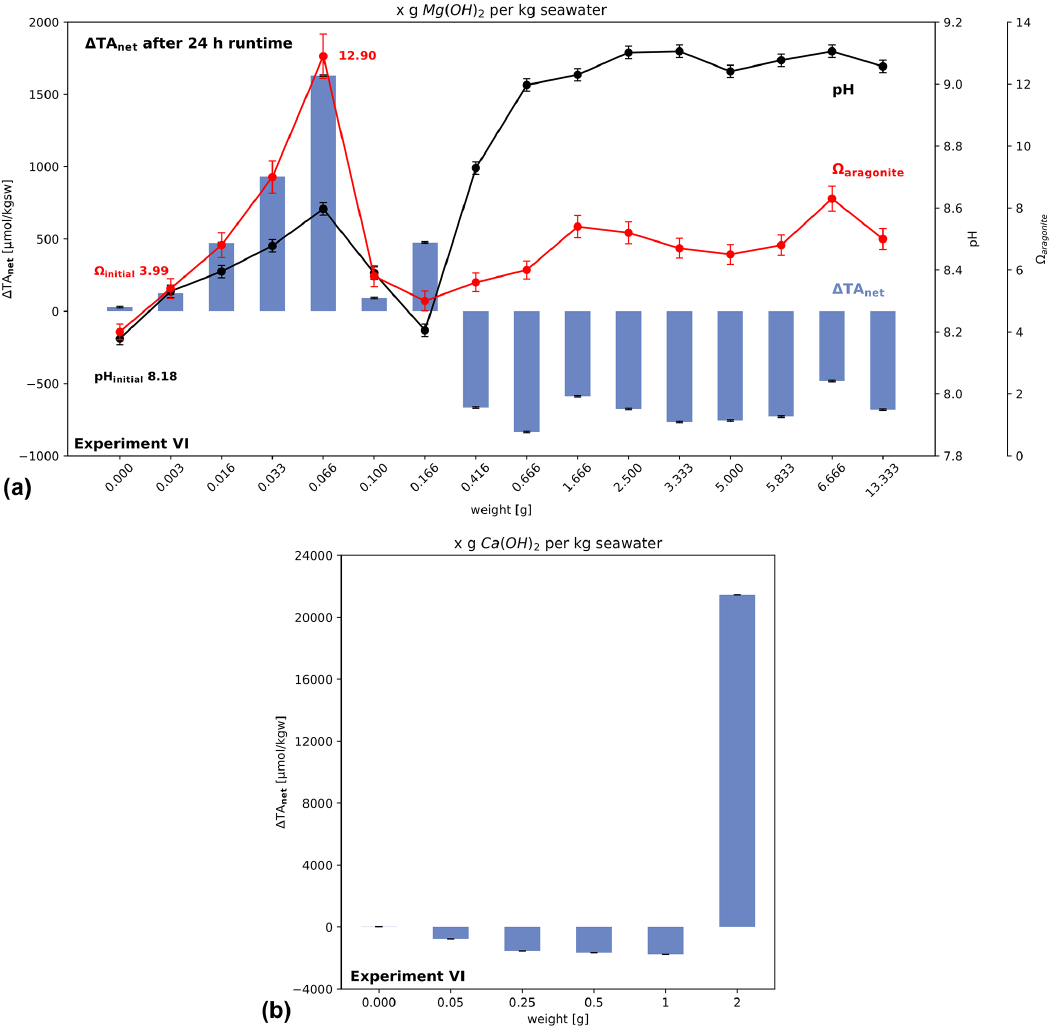
Figure 8. Change in alkalinity after adding Mg(OH) 2 or Ca(OH) 2 to North Sea water in a shaking bath (simulating wave processes to allow accelerated air–water–CO 2 exchange). (a) Net loss occurs when alkalinity addition exceeds the critical saturation level of aragonite, while in (b) it is shown, using Ca(OH) 2 , that for high added amounts of solid the (cid:49) TA net loss can be turned into a gain. Note for data in (b) no pH values are available for calculation of aragonite saturation